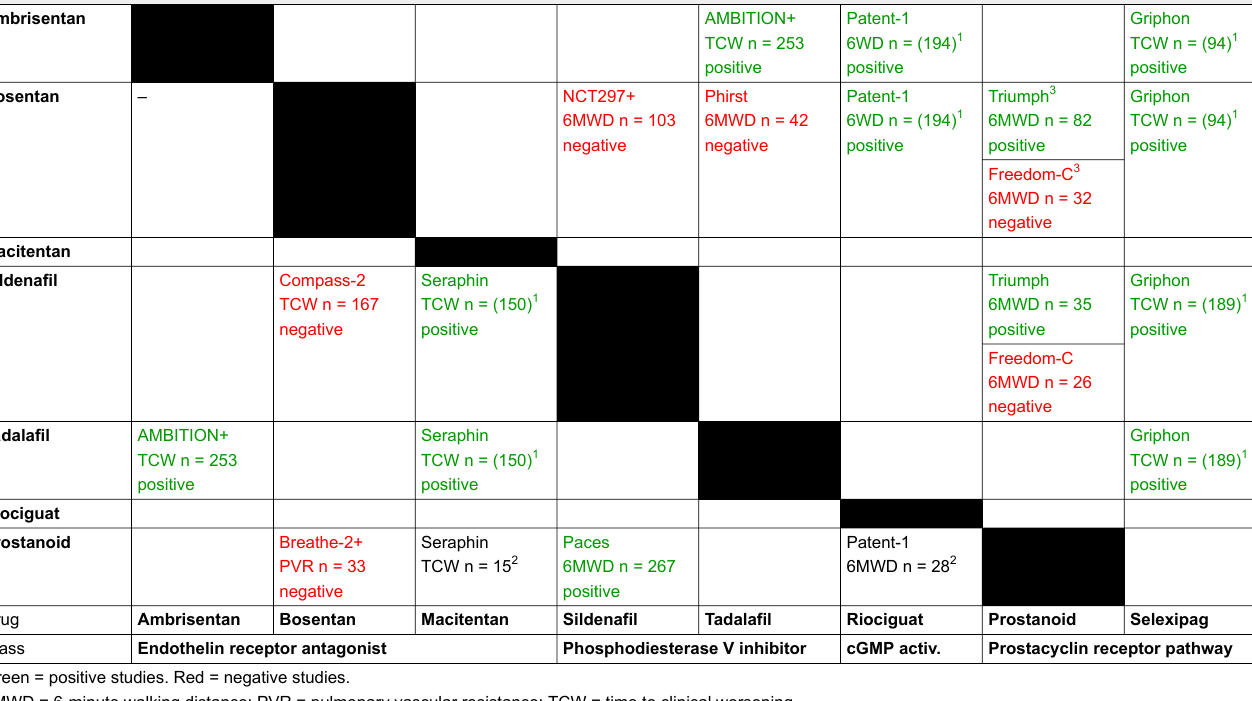
Table 2: Published clinical studies in which double therapy was compared with single therapy plus placebo. In the second to lowest row are the drugs tested against placebo, and in the left-hand column is shown the patients’ existing regimen. In the BREATHE-2 and the AMBITION studies, both drugs were introduced simultaneously. Ambrisentan